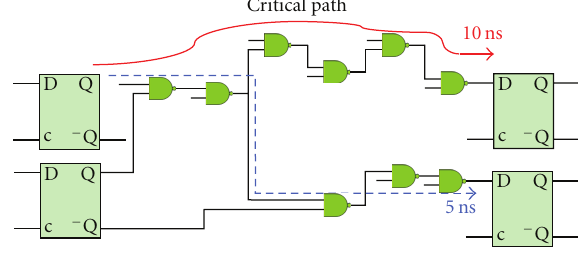
Figure 2: Critical and noncritical paths.